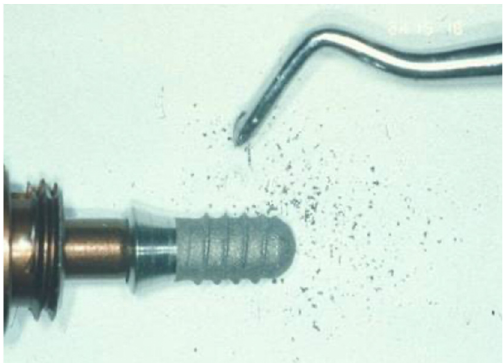
Figure 14. Scaling of the implant surface (Bonefit ® implant with TPS-coating) leading to titanium particles removal and damage of the implant surface due to instrumentation. (Courtesy: Prof. Dr.